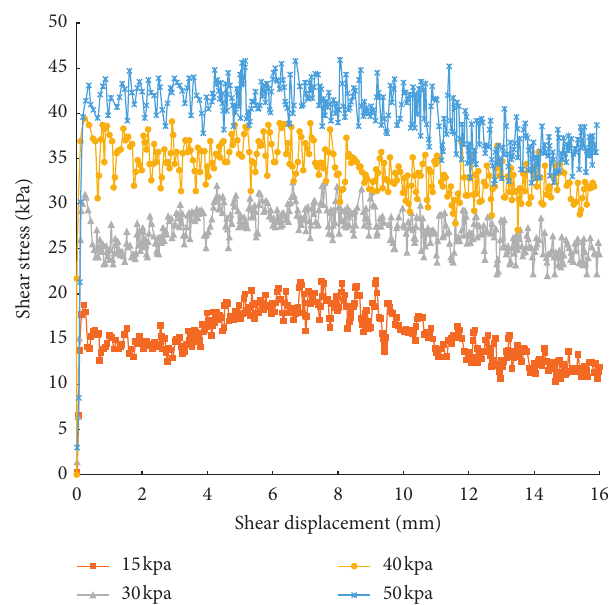
Figure 7: Shear stress-shear displacement curve of 0.6 cm horizontal ring-shaped-reinforced sand.